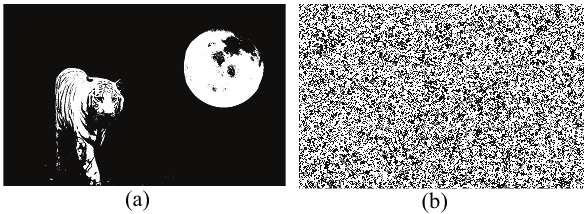
Fig. 6. (a) I2- Model image 2 (175 × 200), (b) Ciphered image of the model image 2.